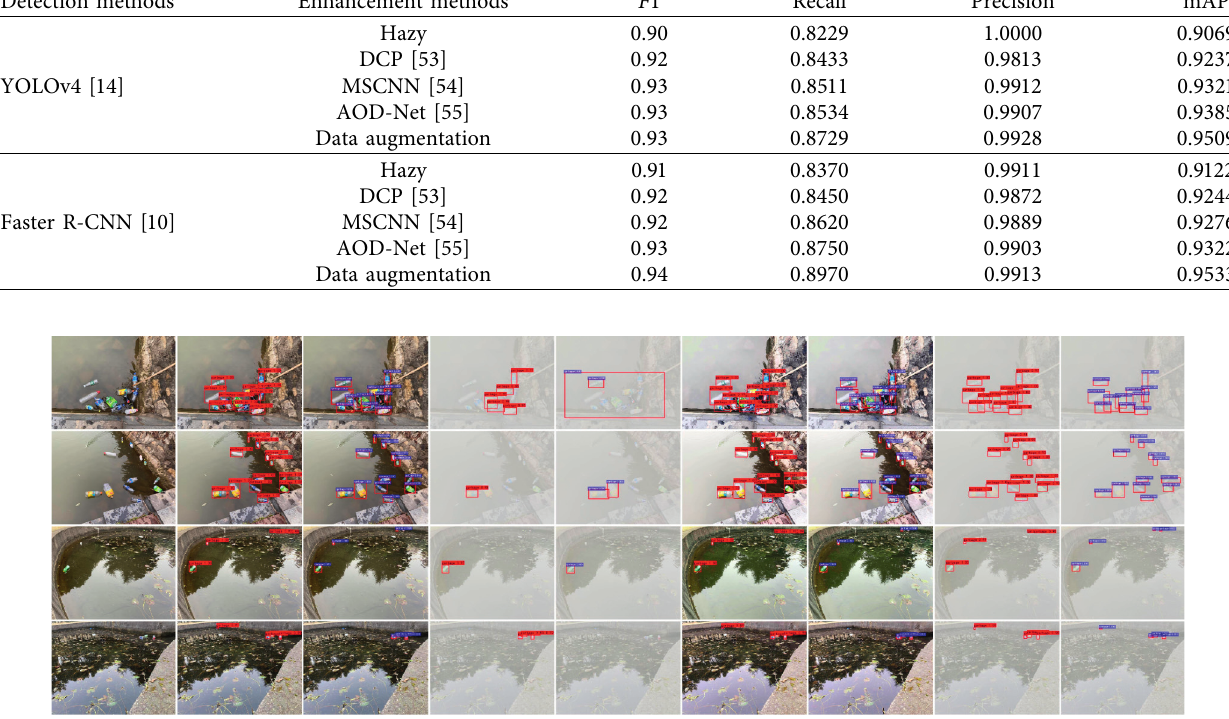
Figure 6: The water-surface garbage detection results under different weather conditions, i.e., hazy, low-light, and rainy conditions. It can be found that the detection accuracy will be dramatically reduced if the image degradation becomes more severe. Table 2: The influences of hazy imaging condition and visibility enhancement on water-surface garbage detection. Detection methods